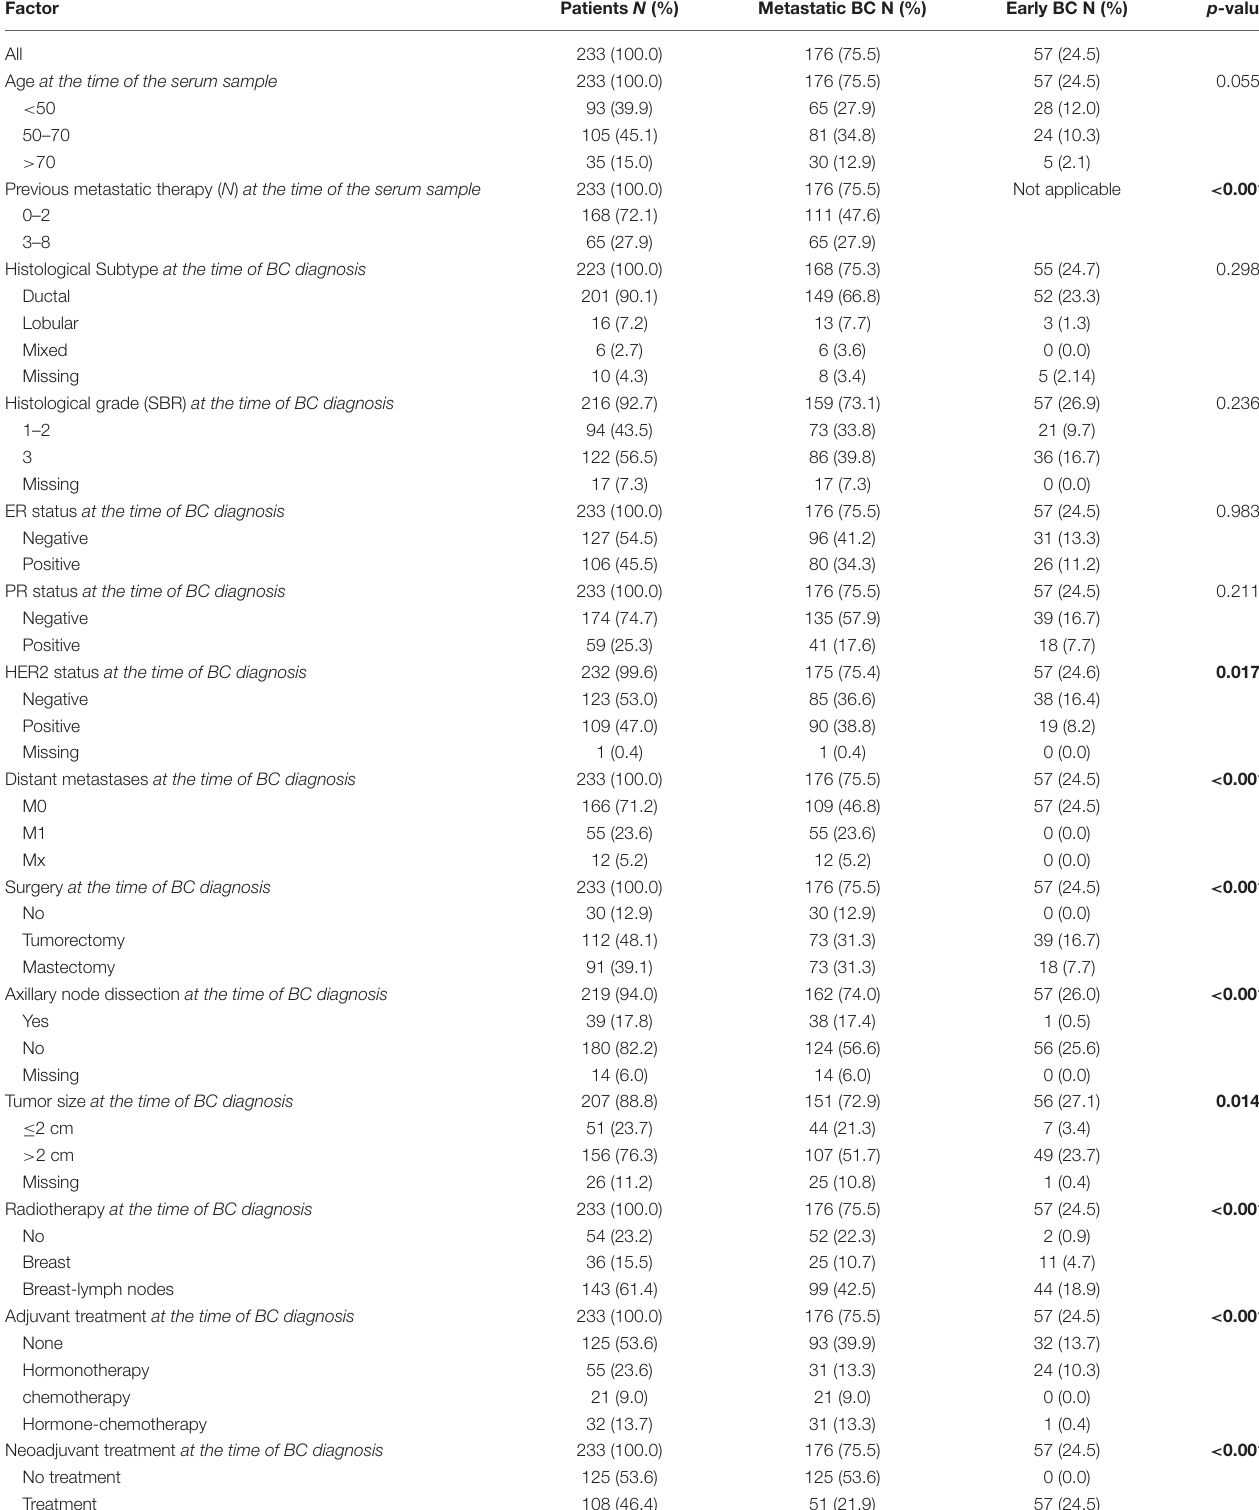
TABLE 1 | Patients characteristics in the metastatic and the early breast cancer groups. Factor Patients N